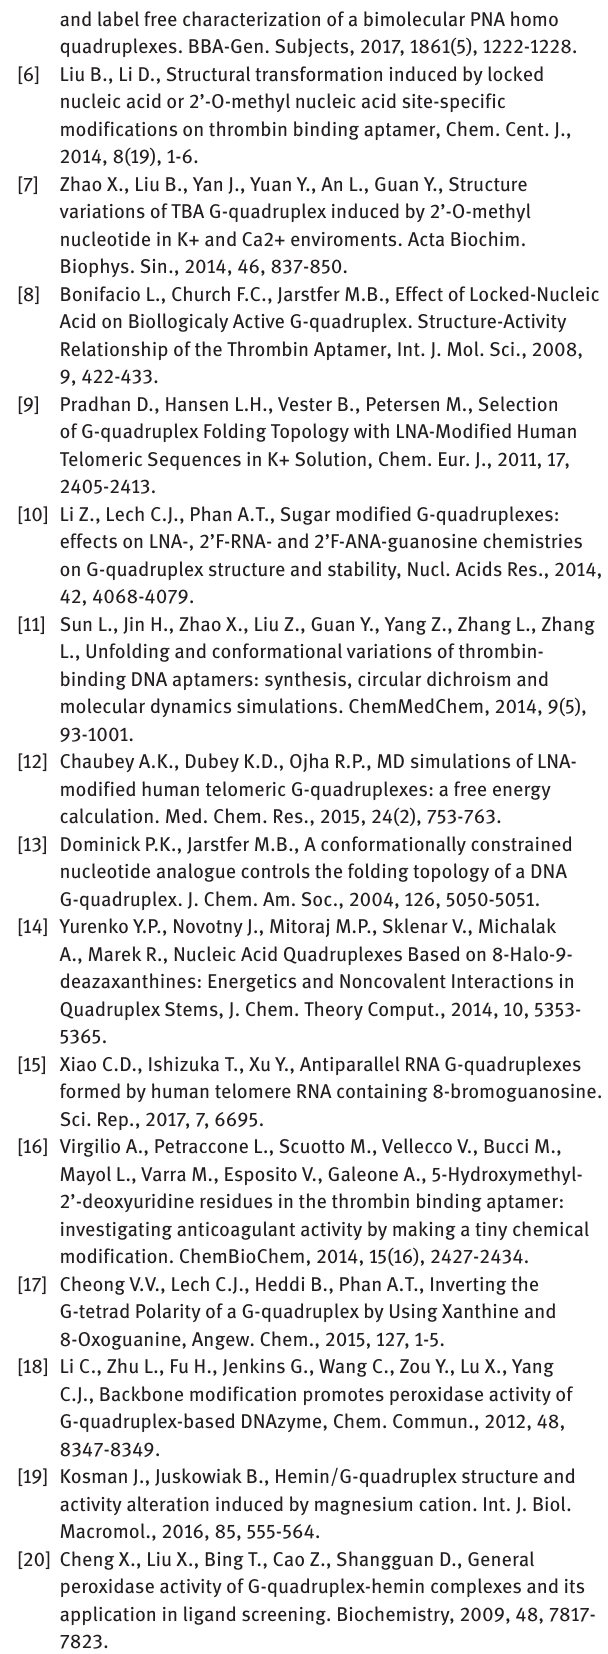
/V ) of HT22 and 0x 0hemin